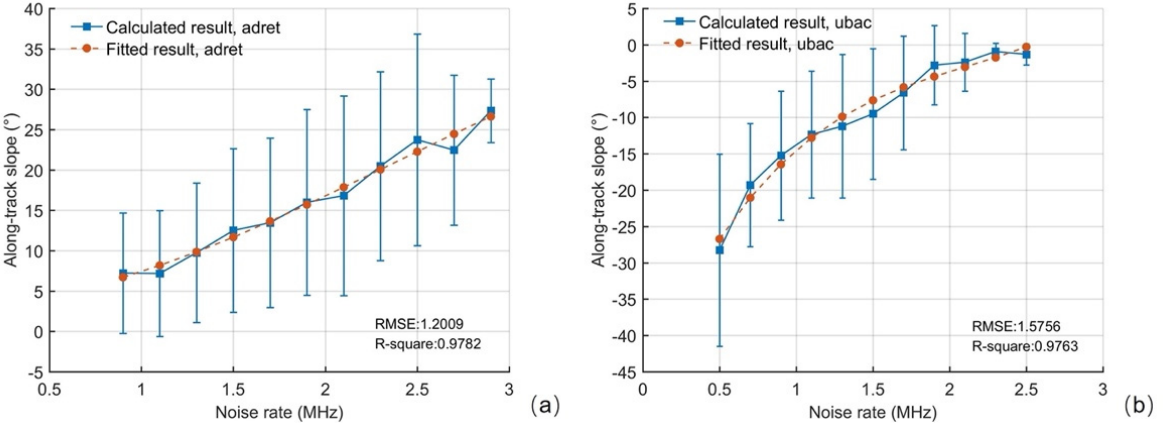
Figure 7. Relationship between the along-track slope σ L and the noise rate f nc . The blue and red curves correspond to the measured results and fitted results, respectively. The mean and standard deviation of the measured along-track slopes with similar noise rates (within the scope of ± 0.1 MHz) were calculated and shown as the error bars. ( a ) The adret slope. ( b ) The ubac slope.